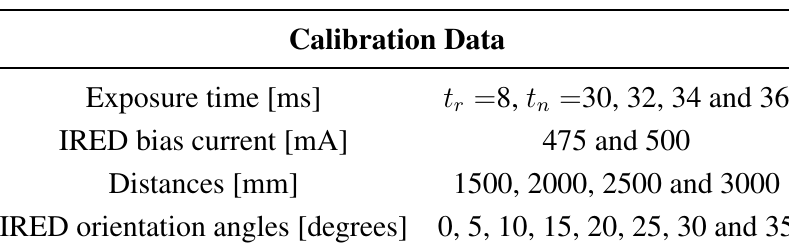
Table 3. Calibration